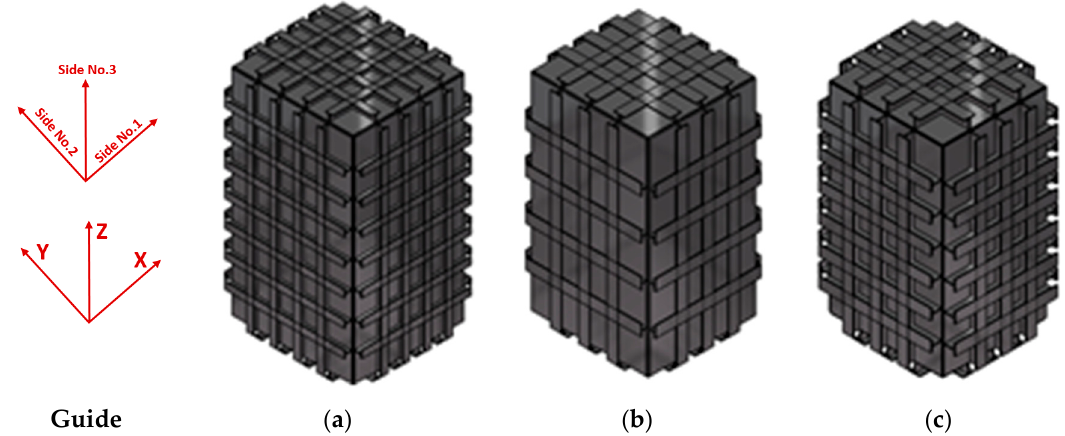
Figure 2. Final structures of reinforced compartments with T-shaped beams: ( a ) steel compartment, ( b ) aluminum compartment (depth of 20 m), and ( c ) aluminum compartment (depth of 60 m). Final structures of reinforced compartments with T-shaped beams are presented in Figure